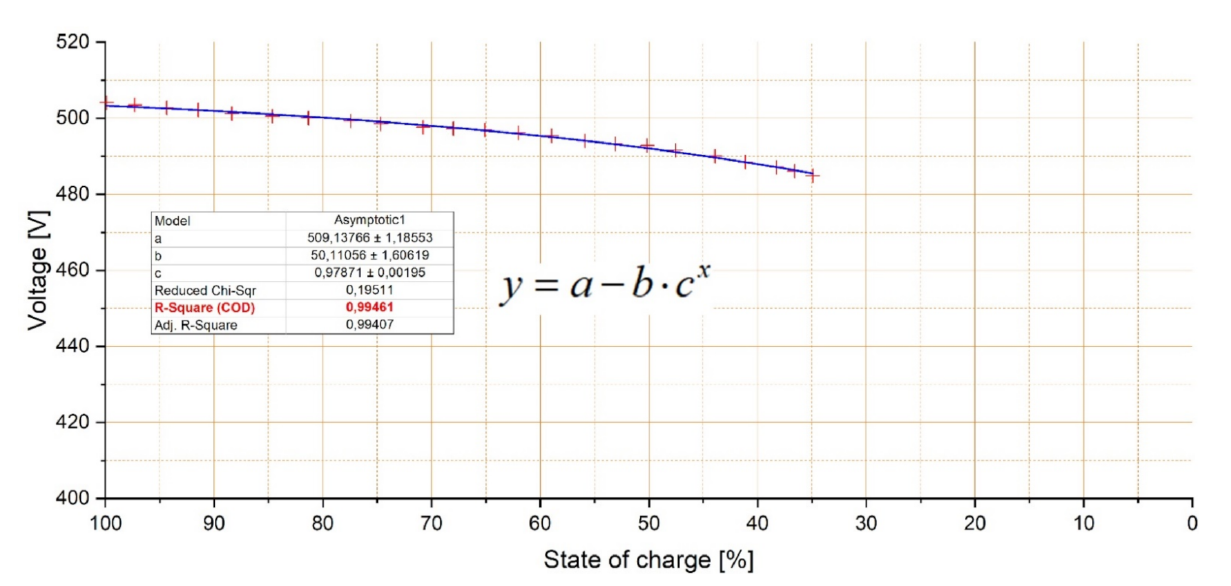
Figure 12. Battery discharge—battery voltage as a function of the state of